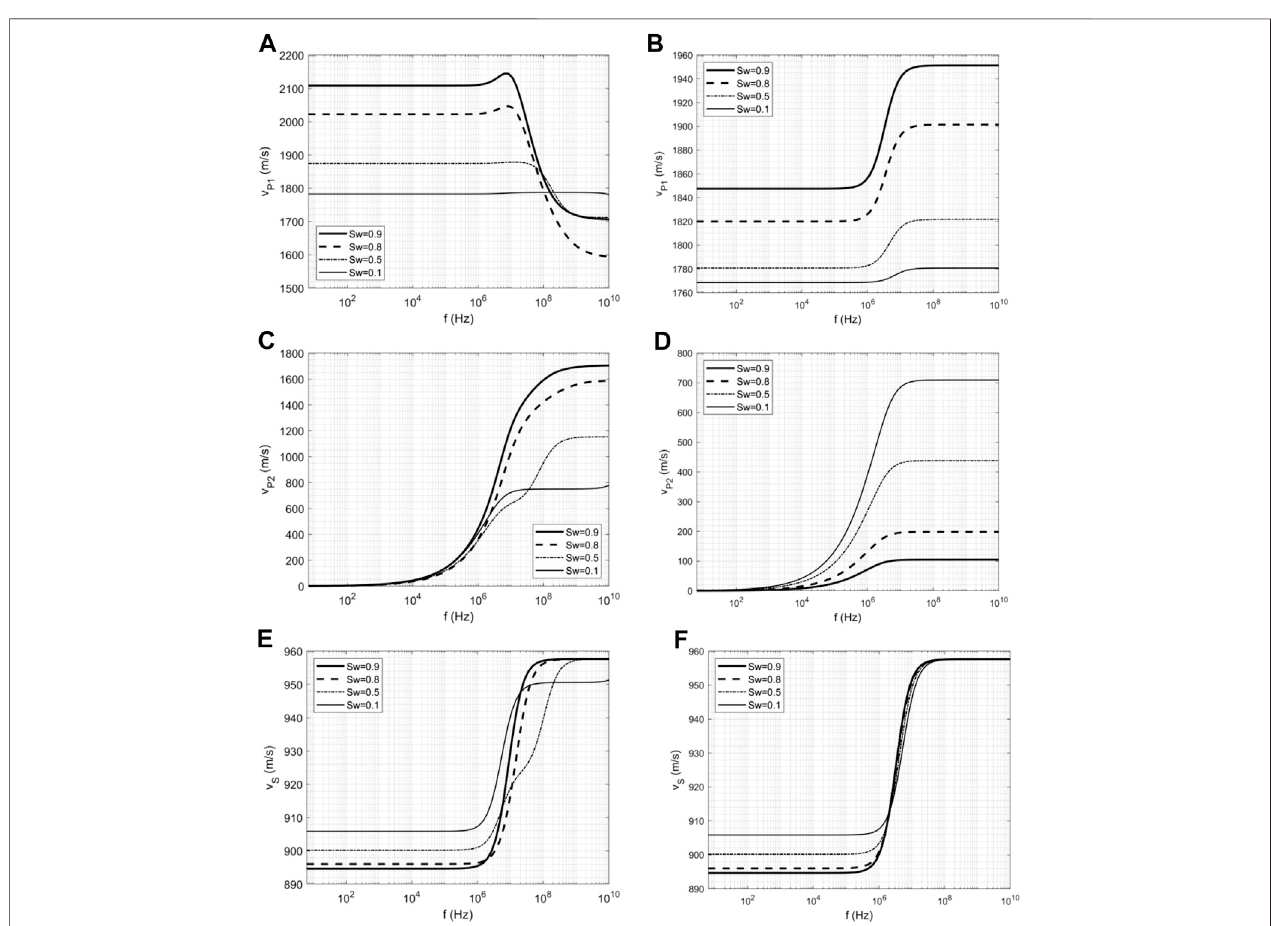
FIGURE 3 | The dispersion curve of seismic wave propagation in a porous media containing oil and water. (A, C, E) are the dispersion curves of the fast P-wave, theslow P-wave and the S-wave corresponding to four saturations calculated by Eq. 1 , respectively; (B, D, F) are those of dispersion curves by the improved model proposed in this